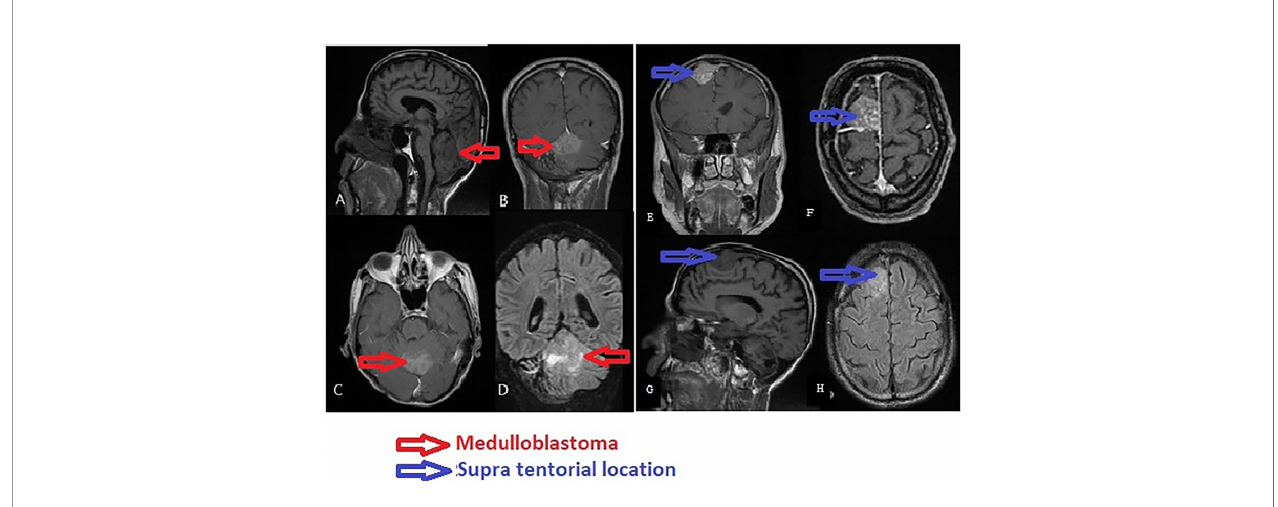
FIGURE 1 | Magnetic resonance imaging of the brain showing glioblastoma of the posterior fossa and frontal meningioma. 1 Glioblastoma. (A) Sagittal T1. (B) Coronary T1-weighted post-gadolinium. (C) Axial T1 post-gadolinium. (D) Coronary fl uid-attenuated inversion recovery (FLAIR). 2 Supratentorial location: probable meningioma. (E) Coronary T1 post-gadolinium. (F) Axial T1-weighted post-gadolinium. (G) Sagittal T1 plane showing the scalloping. (H) Axial